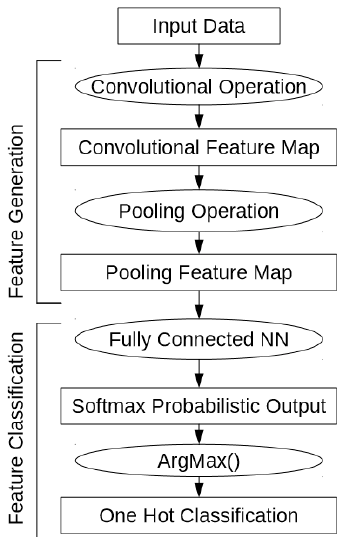
Figure 5. Convolutional Neural Network (CNN) flow diagram.